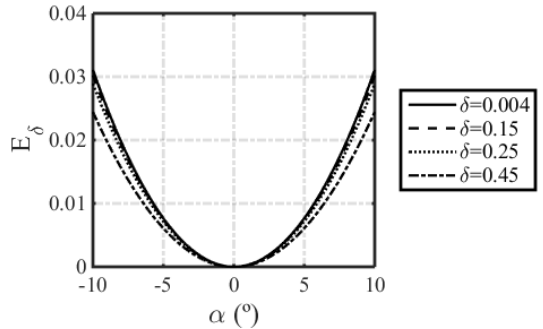
Figure 3. Difference E δ between the simulated and the real δ , de- pending on the misalignment angle of the polarizing plane of the laser ( α) for different δ